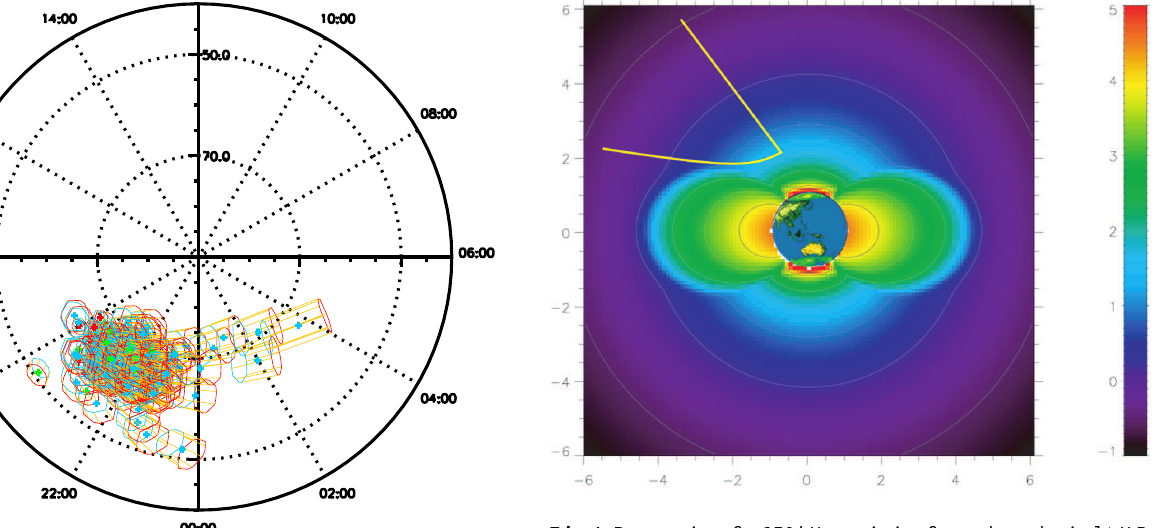
Fig. 4. Ray tracings for 250kHz emission from a hypothetical AKR source at 2 R E to spacecraft at 60 ◦ (a) and 10 ◦ (b) geomagnetic latitude. The plasmaspheric model, in pseudo-color coded electron density, (logarithmic levels), is from Gallagher et al. (2000) with geomagnetic index K p =